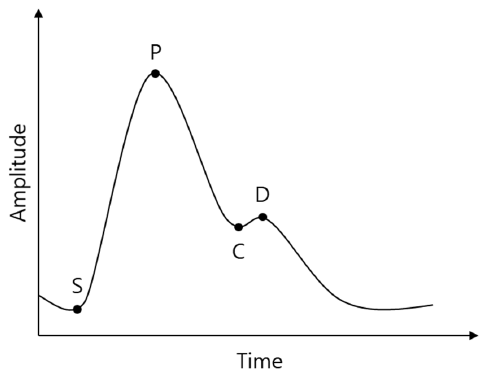
Figure 1. cPPG feature points: S, start point; P, systolic peak; C, dicrotic notch; D, diastolic peak.